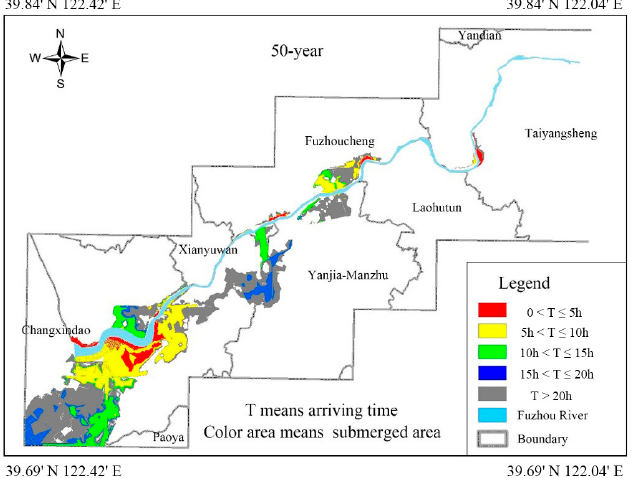
Figure 9. Submerged depth of 20-year return period scenario (Depth in here means maximum depth of the same point during the total flood process). As can be seen in Figures 10 and 11, compared with the 20-year return period sce- nario, the breaches appear earlier in the 50-year return period scenario, and the